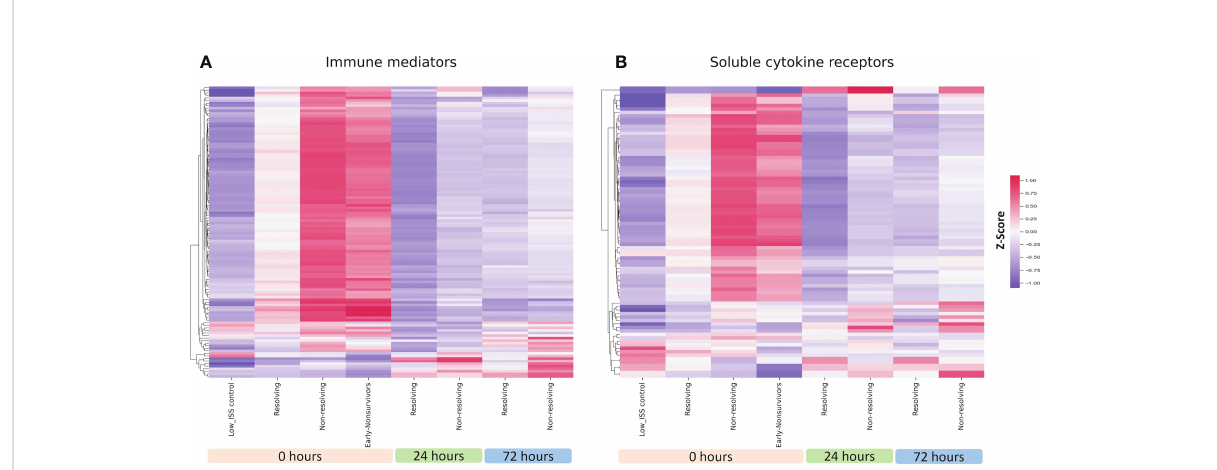
FIGURE 1 Heatmap illustrating normalized z-scores for all 115 assayed immune mediators (A) and 69 soluble cytokine receptors (B) in ENS (n=38), NR (n=78), and R (n=34) patients at 0, 24 and 72 h with low ISS (ISS of 1 or less, n=29) patients as